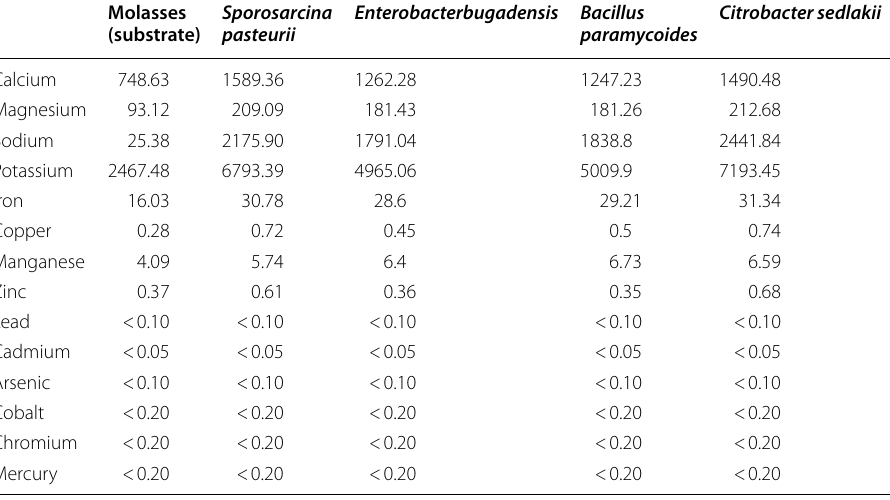
Table 4 Exchangeable cations and heavy metals concentrations (mg/kg) of molasses and bioenzyems